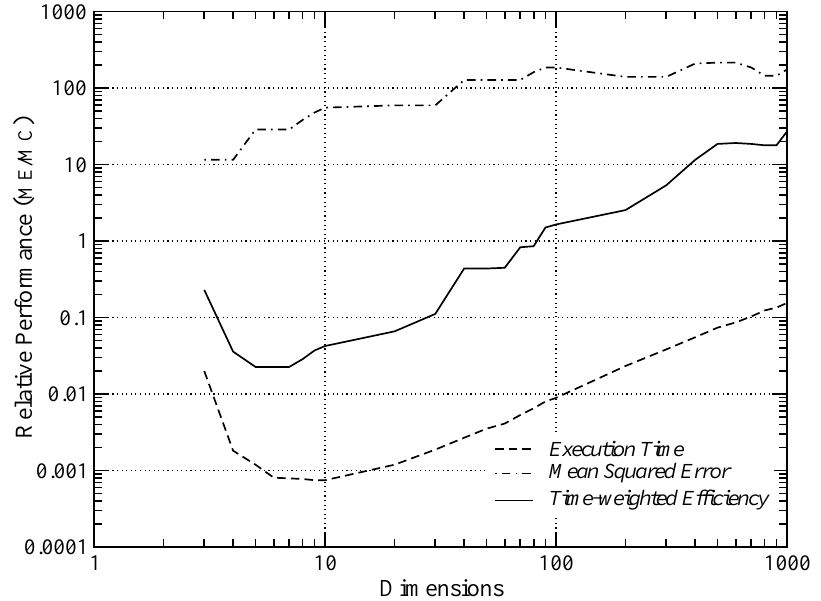
Figure 3. Relative performance of Genz Monte Carlo ( MC ) and Mendell-Elston ( ME ) algorithms: ratios of execution time, mean squared error, and time-weighted efficiency. ( MC only: mean of 100 replications; requested accuracy (cid:101) =